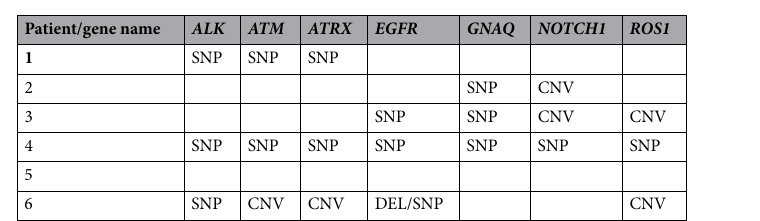
Figure 1. Venn diagrams showing the overlapping genetic alterations detected between tDNA and cfDNA from the same patient. ( A ) The grey area in (a) represents the common alterations detected in both the tDNA and cfDNA samples. The blue area in (b) represents the common alterations detected among each tDNA and cfDNA sample from the same individual patient. The orange area in (c) represents the alterations detected exclusively in the cfDNA samples. The green area in (d) represents all of the alterations detected in the tDNA. ( B ) Overlapping genetic alterations between the tDNA and cfDNA samples of each patient. In patient #3, as an example, of the 97 alterations found in the primary lesion, 34 were also detected in cfDNA, whereas 63 or 53 alterations were identified exclusively in tDNA from the primary lesion or in cfDNA, respectively. Furthermore, there were 24 common alterations among the tDNA samples extracted from the primary lesion and the 2 metastatic lesions and the cfDNA sample of patient #3. ( C ) There was no correlation between the tumor genetic alteration detectability in cfDNA and tumor size. The X axis presents cfDNA mutation detection rate (= grey area/green area in A ) and the Y axis presents each tumor size. Abbreviations: cfDNA, cell-free DNA; rt., right; lt., left; mets, metastasis.